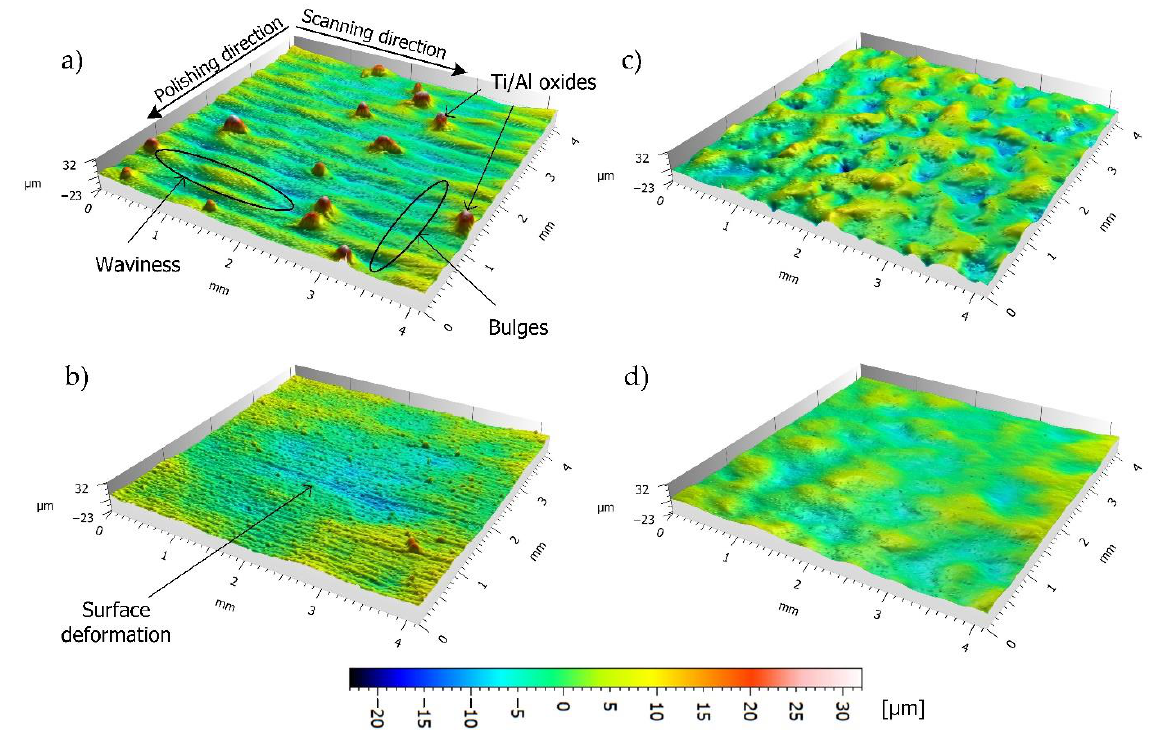
Figure 8. Laser Polished surface topographies recorded by white-light interferometry: ( a ) OL = 50% (air, 1.o), ( b ) OL = 85% (air, 5.o), ( c ) OL = 50% (argon, 1.a), and ( d ) OL = 85% (argon, 5.a).